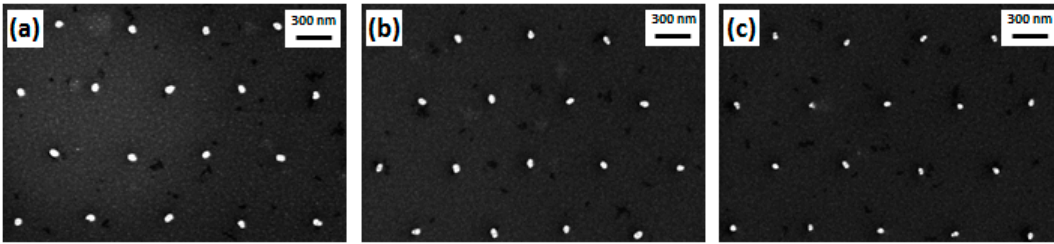
Figure 4. Top-view SEM images of Si nanopillars with different diameters resulting from corresponding different doses: ( a ) 40 µC/cm 2 ; ( b ) 34 µC/cm 2 ; ( c ) 28 µC/cm 2 .